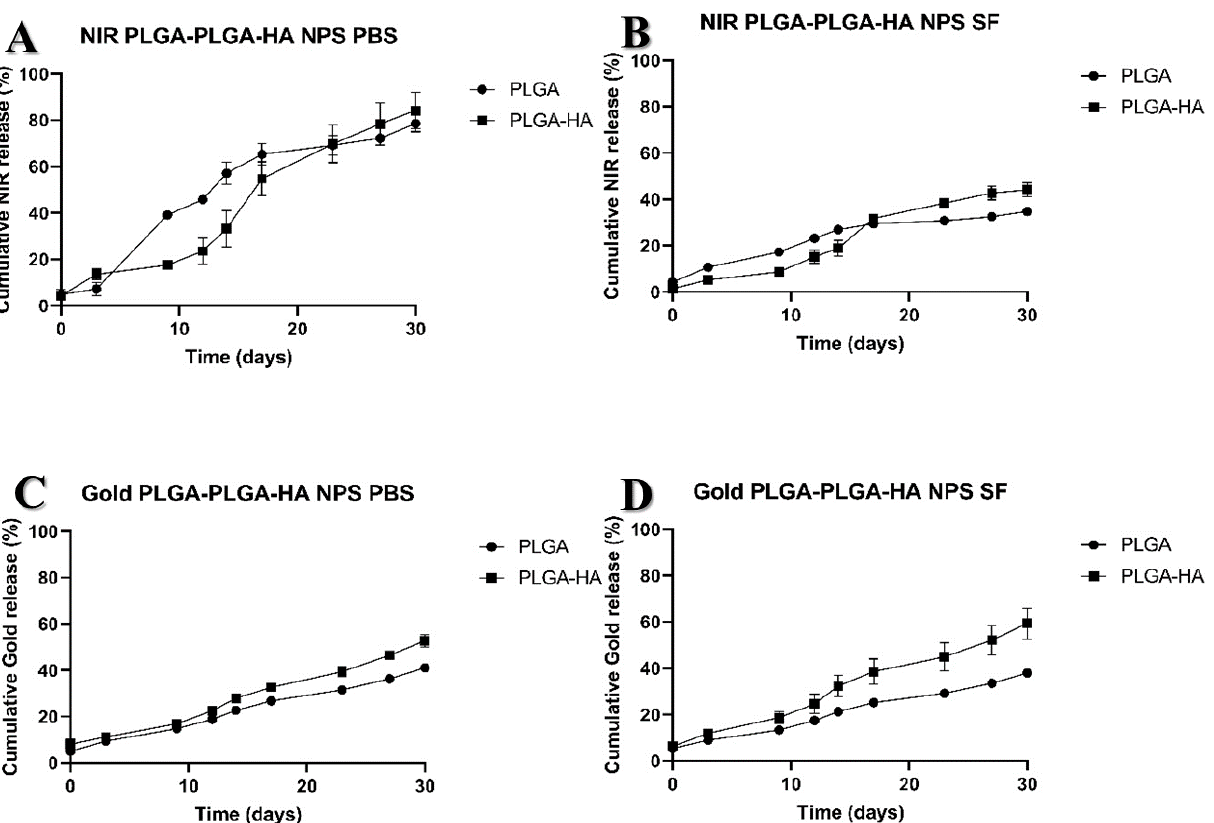
Figure 4. Release study of NIR dye and gold particles from PLGA NPs and PLGA-HA NPs in PBS and in SF. ( A ) Cumulative release of NIR dye in PBS, ( B ) cumulative release of NIR dye in SF, ( C ) cumulative release of gold in PBS, and ( D ) cumulative release of gold in SF.